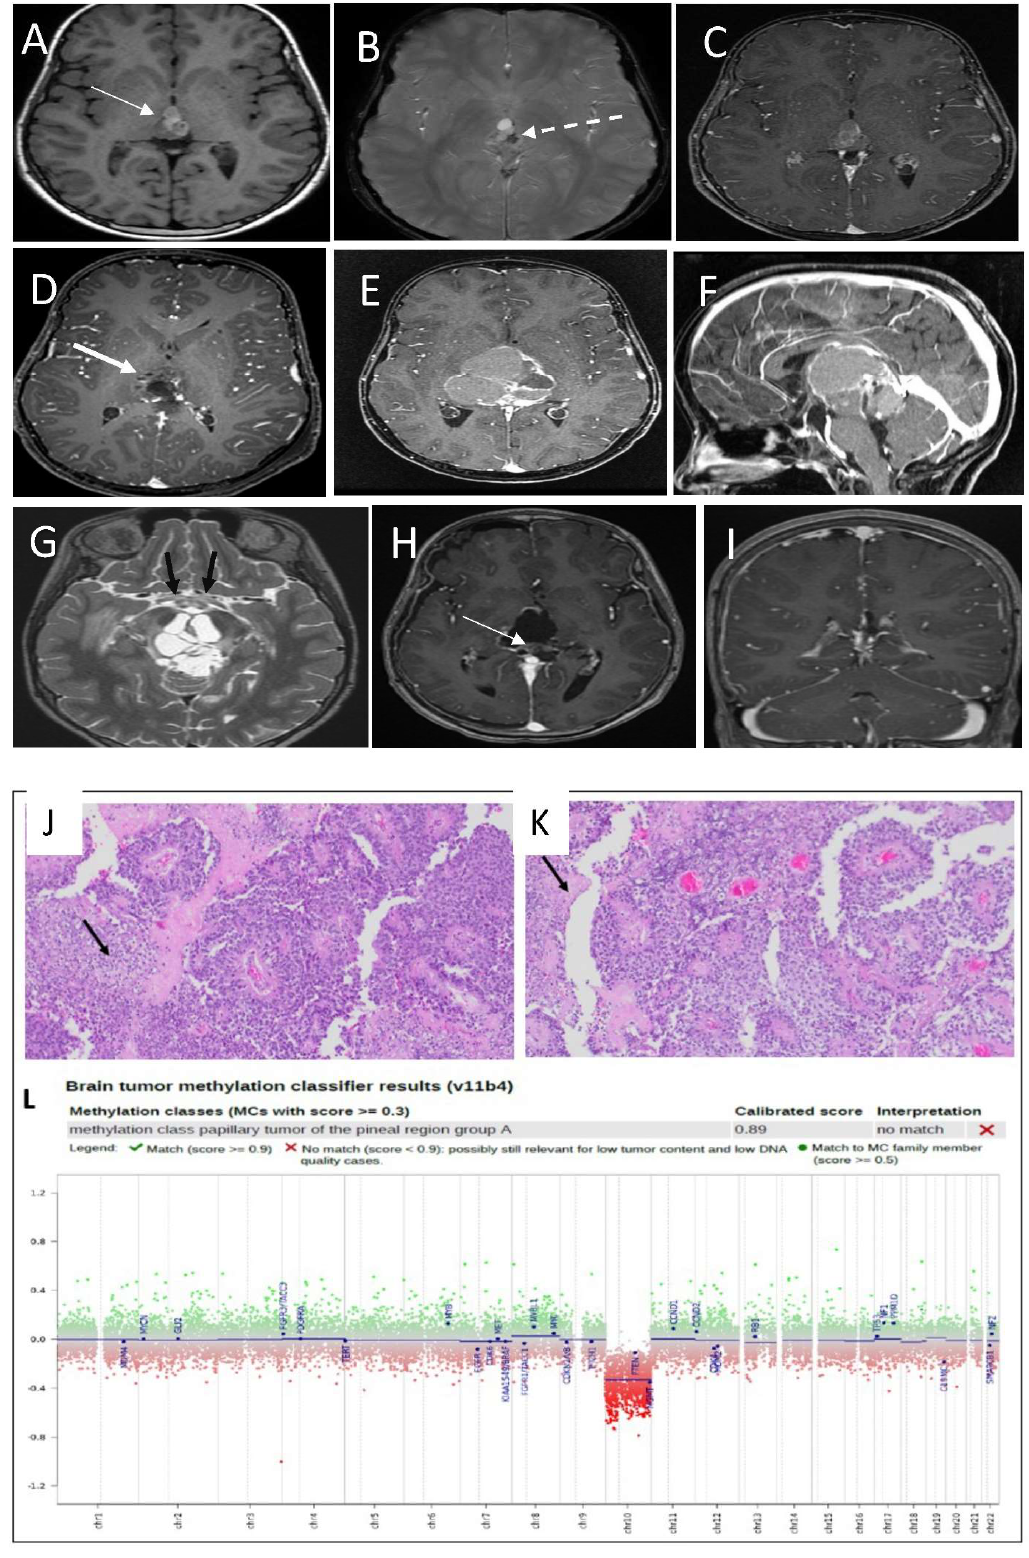
Figure 2. ( A ) Non-enhanced T1 SE WI shows a complex lesion with multiple areas of hyper-intensity within the lesion (thin white arrow). ( B ) MRI susceptibility weighted image shows areas of